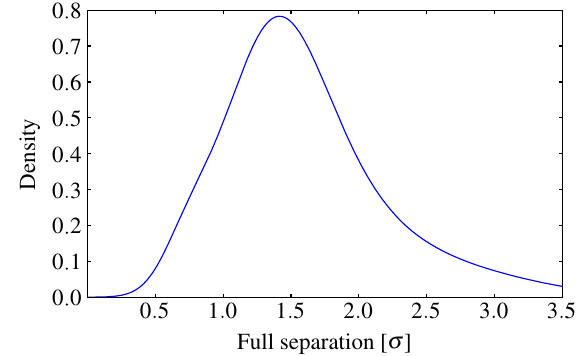
FIG. 15. Kernel density estimation of the separation between the beams at the moment of the instability. 30 occurrences are considered with an uncertainty of 24% on the measured sepa- ration, accounting for bunch to bunch variations of the emittance (10%) as well as for the error on the β (cid:1) at the IPs 1, 5, and 8 [25].